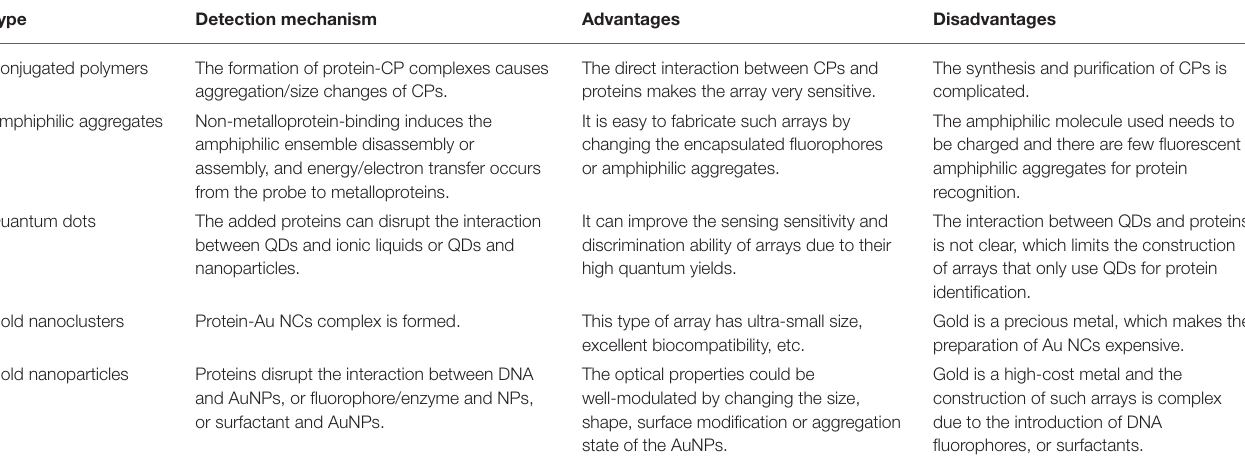
TABLE 1 | Summary of different types of multi-element-based sensor